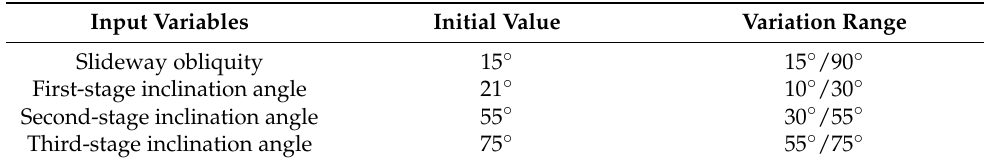
Table 9. Values of the optimization